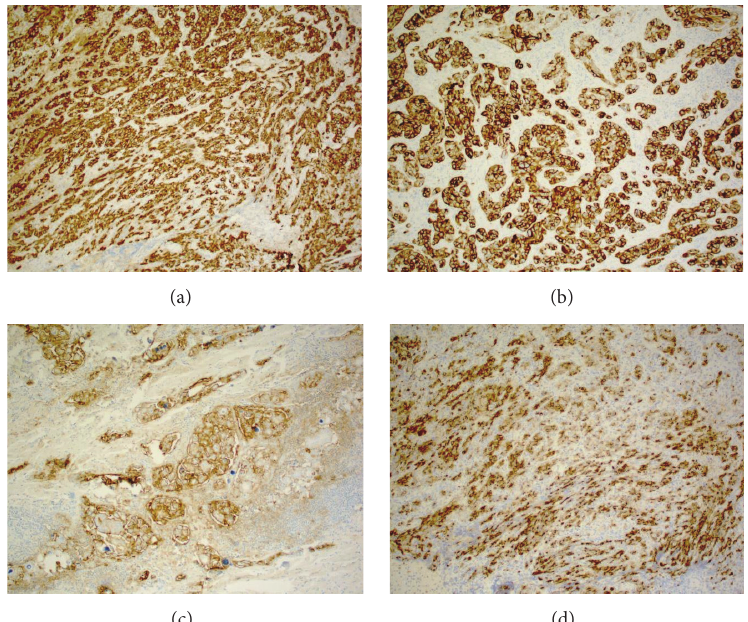
Figure 6: The tumor cells were strongly positive for CK7 (a), CK19 (b), CA19.9 (c), and MUC1 (d) (immunohistochemical staining, 100x).